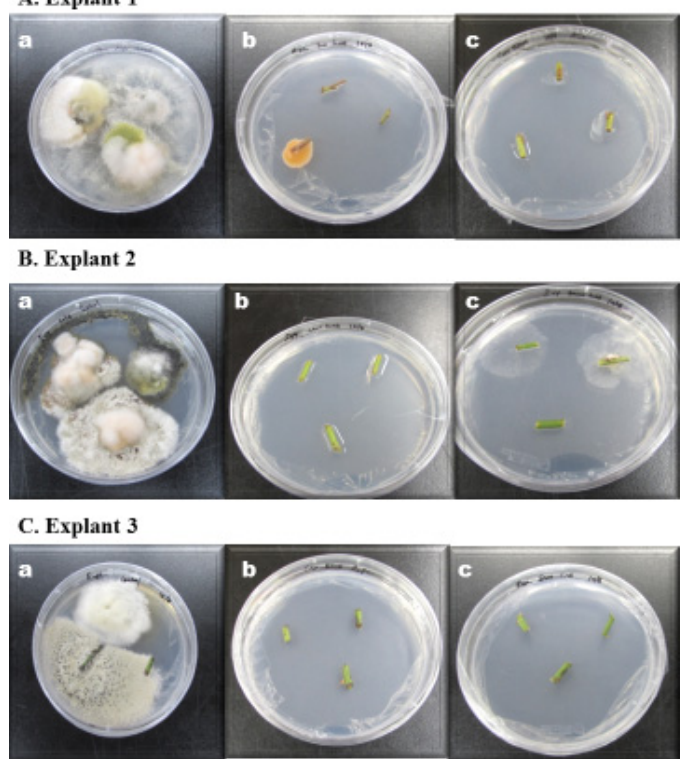
Figure 3. Photographs showing the results of the fumigation effect on explants versus the control. ( A ) Explant 1, ( B ) Explant 2, and ( C ) Explant 3; (a) Control (b) Tur (c) BR. Details are given in above text.